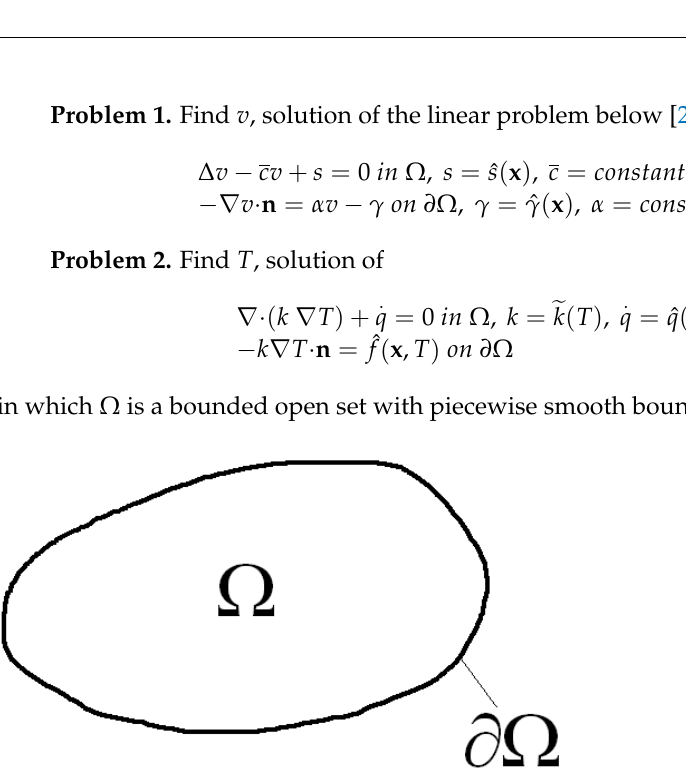
Figure 1. The bounded open set Ω and its boundary ∂ Ω